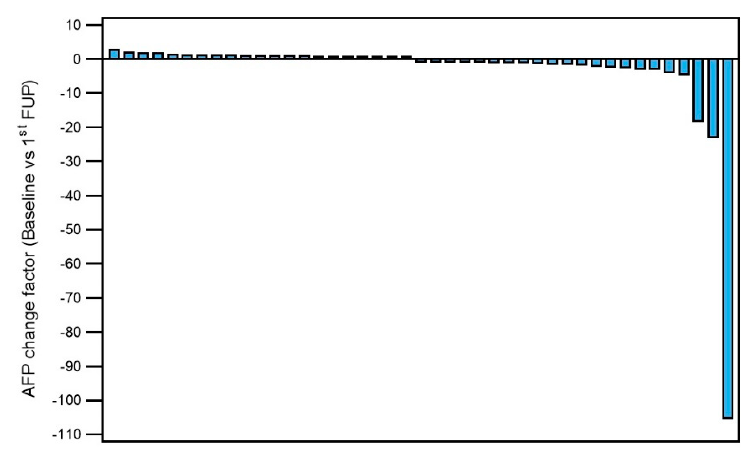
Figure 3. Alpha-fetoprotein (AFP) change between baseline and first follow-up.